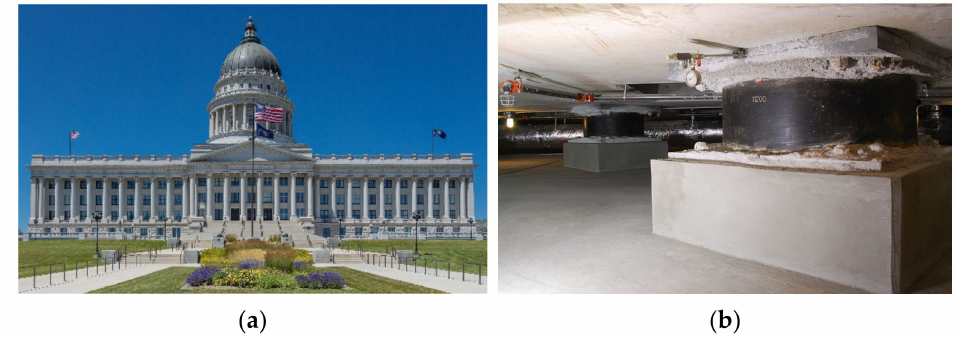
Figure 3. Utah State Capitol building ( a ) and the seismic dampening widgets (base isolators, ( b )).